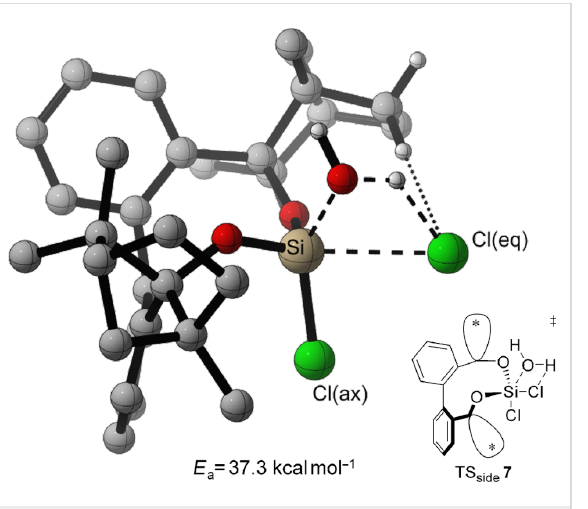
Figure 8: Transition state leading to 8 eq following side attack ( E a = 37.4 kcal mol − 1 , Figure 5, Table 3, entry 3). Breaking and forming bonds in dashed lines, additional C–H-interactions with dotted lines (M06-2X-D3/6-311++G(d,p)(PCM=THF)//B3LYP-D3BJ/6-31G(d) at 298 K).